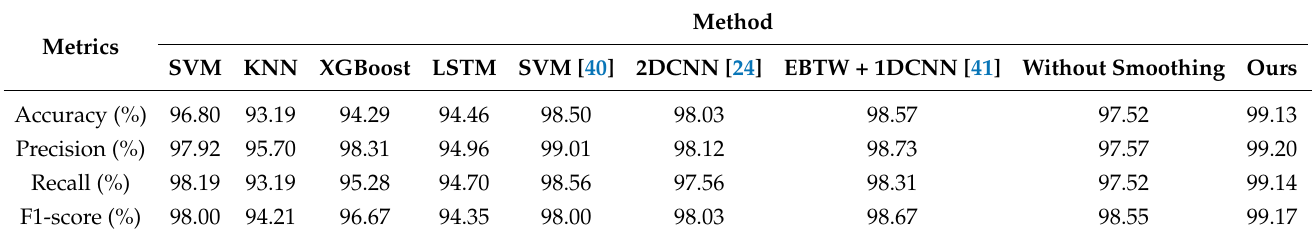
Table 3. Comparison of evaluation index results between ours and the other seven